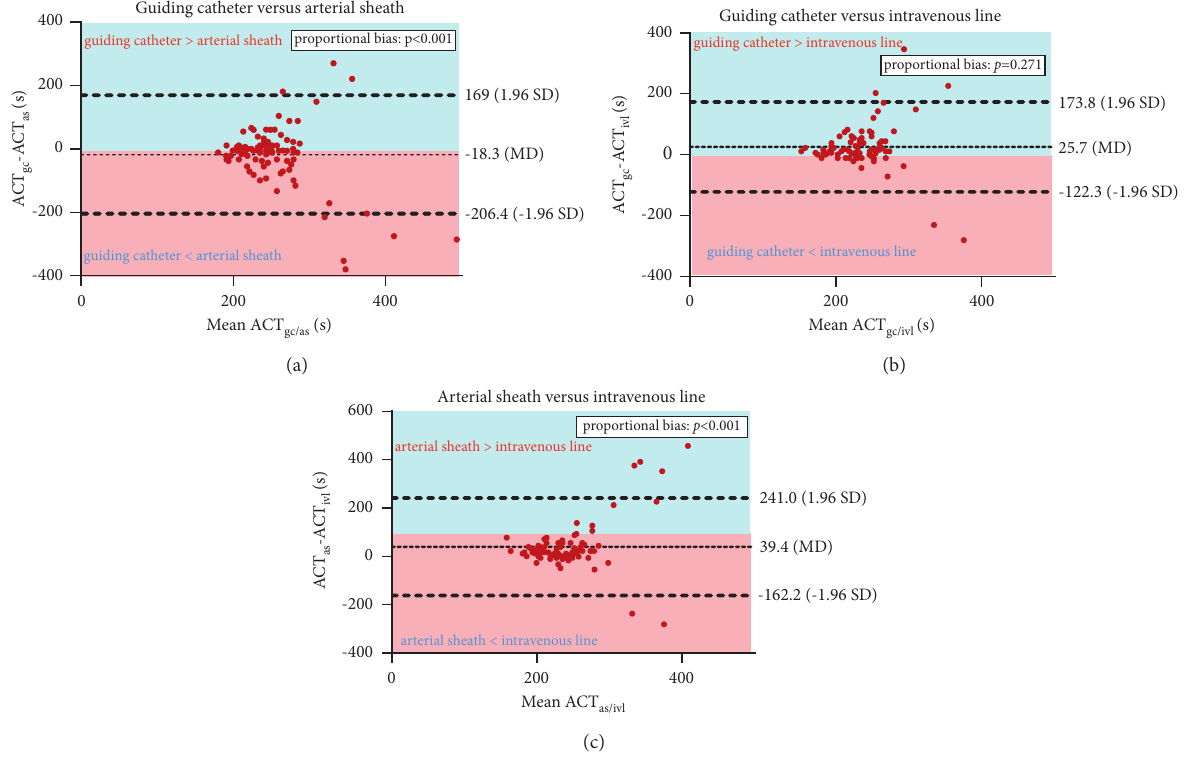
Figure 2: Bland–Altman plots of three ACT sample site comparisons. ACT � activated clotting time; AS � arterial sheath; GC � guiding catheter; IVL � peripheral intravenous line; MD � mean difference; and SD � standard deviation. Systematic differences in ACT between the (a) guiding catheter and arterial sheath, (b) guiding catheter and intravenous line, and (c) arterial sheath and intravenous